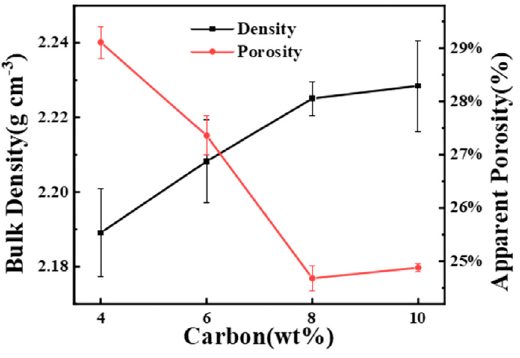
Figure 6. Bulk density and porosity of preforms with different CB contents.